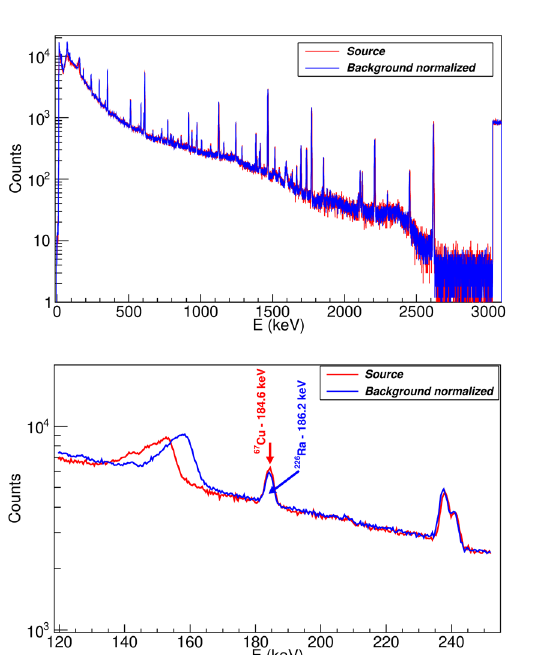
Fig. 5. (Color online ) The γ -ray spectrum obtained during an accumulation period of 40 h, starting 7.5 d after the end of the irradiation in comparison with the background spectrum normalized for the measurement